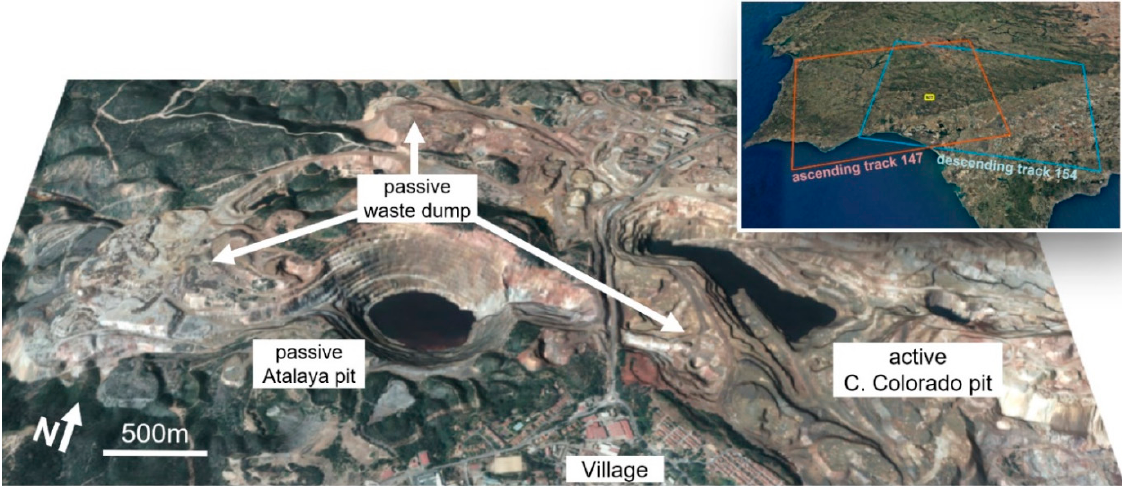
Figure 1. Main mining elements in Riotinto mine. The mining site is divided into one active zone to the east and one passive zone to the west. The small map shows the localization of the Riotinto’s mine (yellow square) and the Sentinel-1 footprints, ascending (red) and descending (blue), of the selected tracks to be used in Section 4. In this specific configuration, both incidence angles on Riotinto are close to 42°.